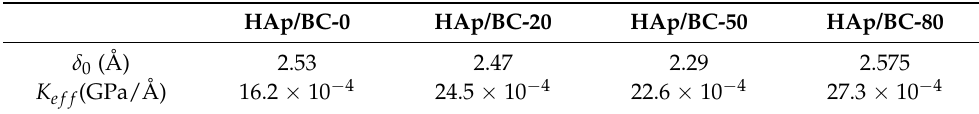
Table 5. Parameters of the interface separation (i.e., 85% of the BC constraint), for the sliding- mode